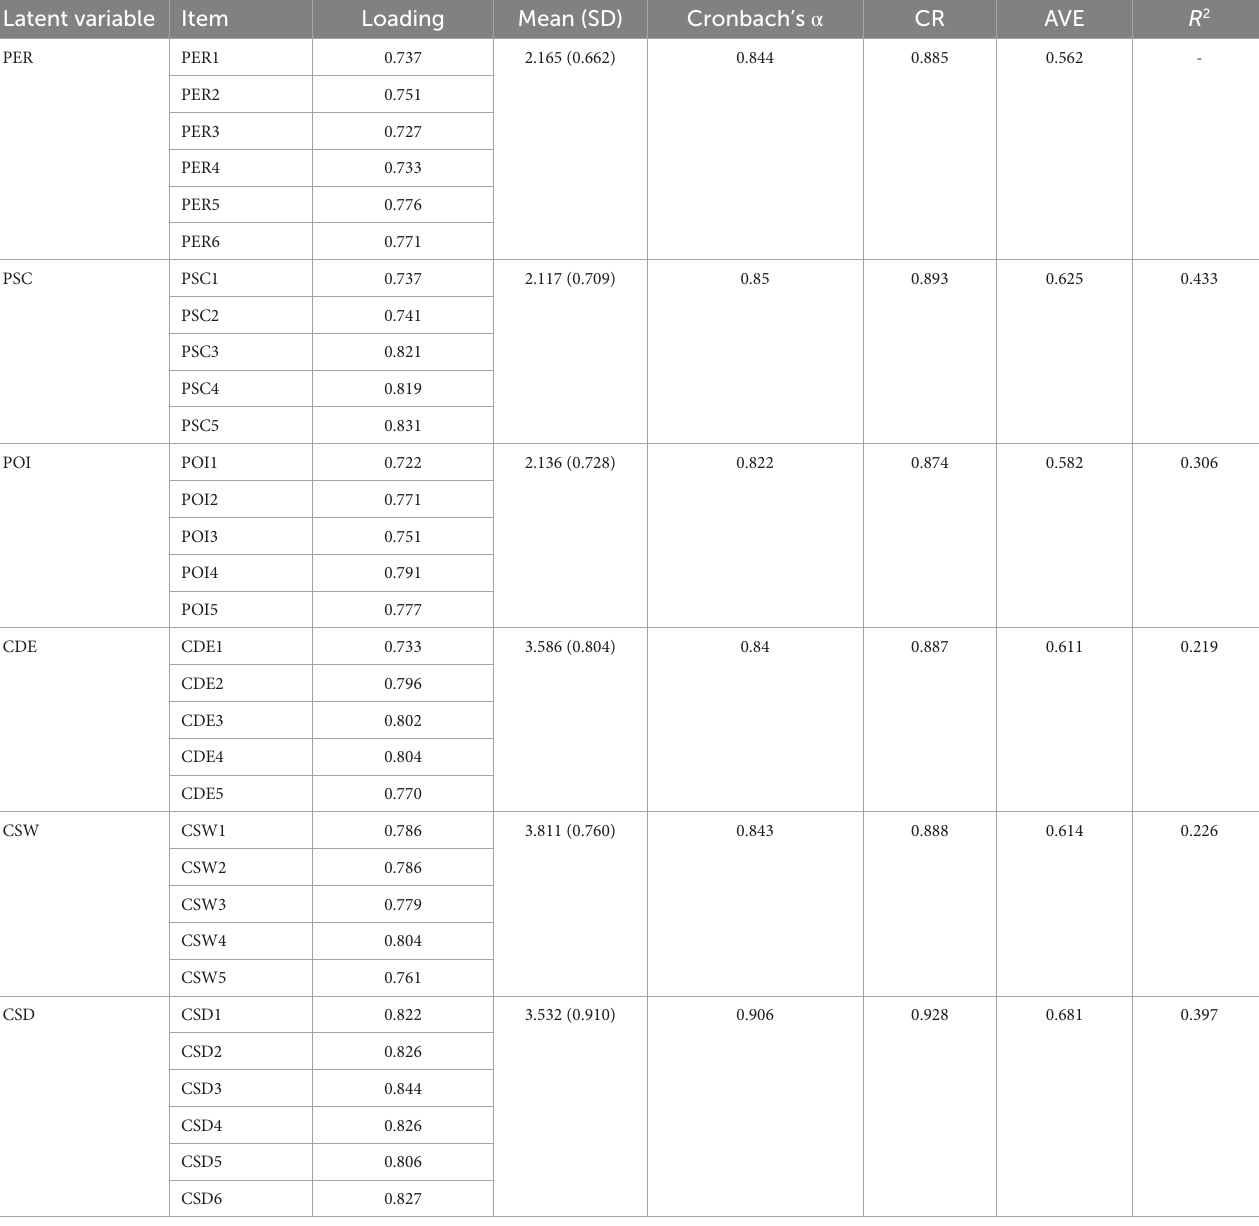
TABLE 1 Reliability and validity of constructs. Latent